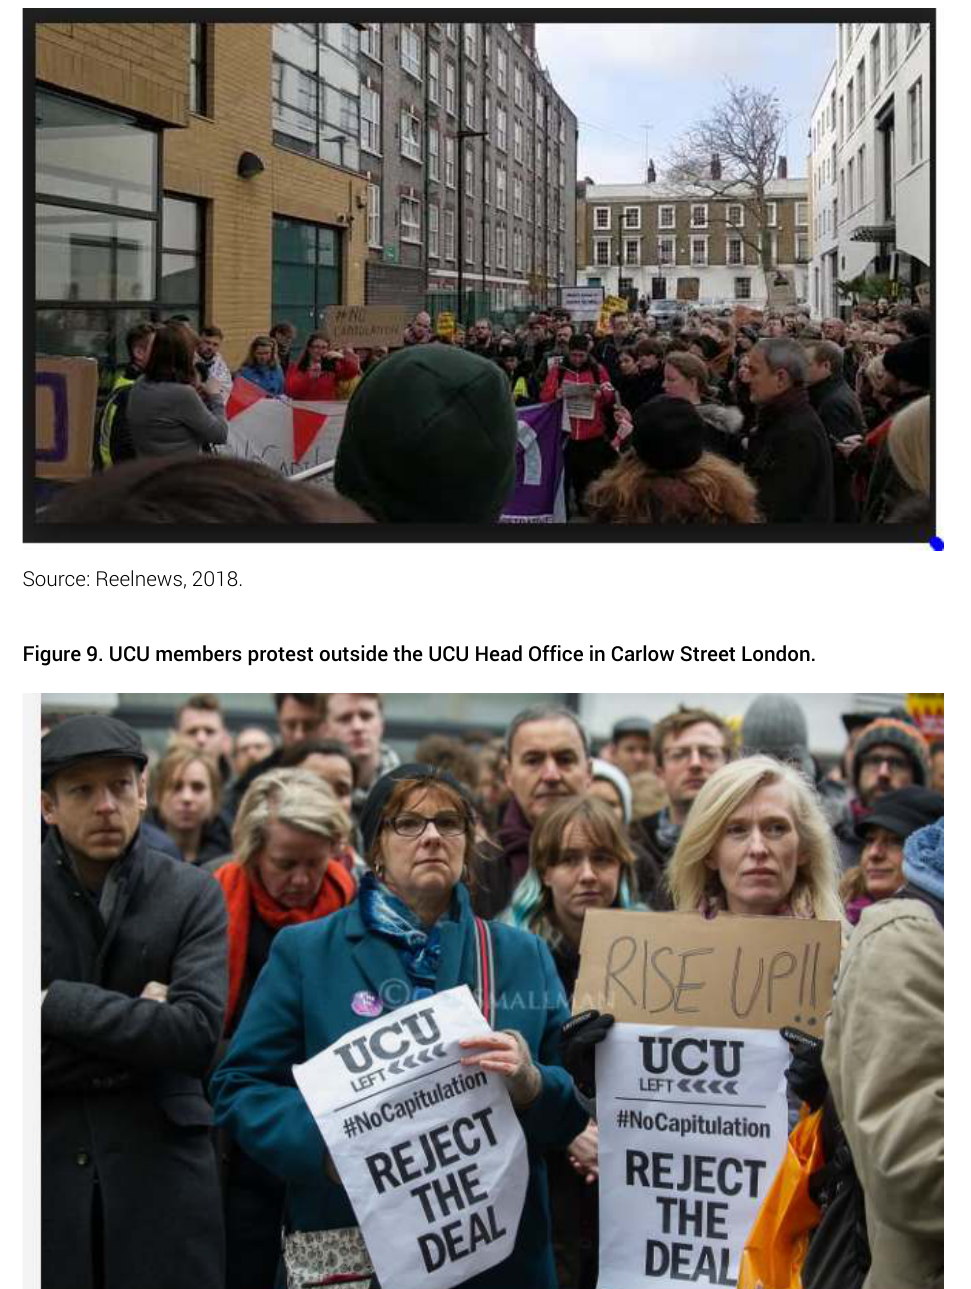
Figure 8. UCU members protest outside the UCU Head Office in Carlow Street London